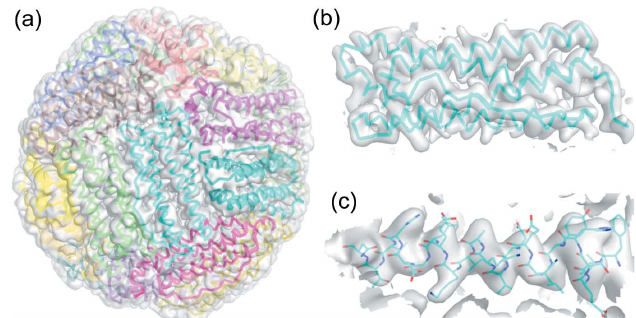
Figure 3 Single-particle reconstruction and refined model based on apoferritin data obtained from sample 1, which was deposited on a Quantifoil grid and plunge-cooled in boiling LN 2 . ( a ) Apoferritin model placed into surface map representation. Ribbons of apoferritin monomers colored by chain designation. ( b ) Single monomer of apoferritin showing map- monomer fit. ( c ) Apoferritin helix comprised of residues 132–154 demonstrating the sidechain fit. Maps in ( a )–( c ) are contoured at 1 (cid:2) . The Fourier shell correlation (FSC) plot is shown in Fig. S7( a